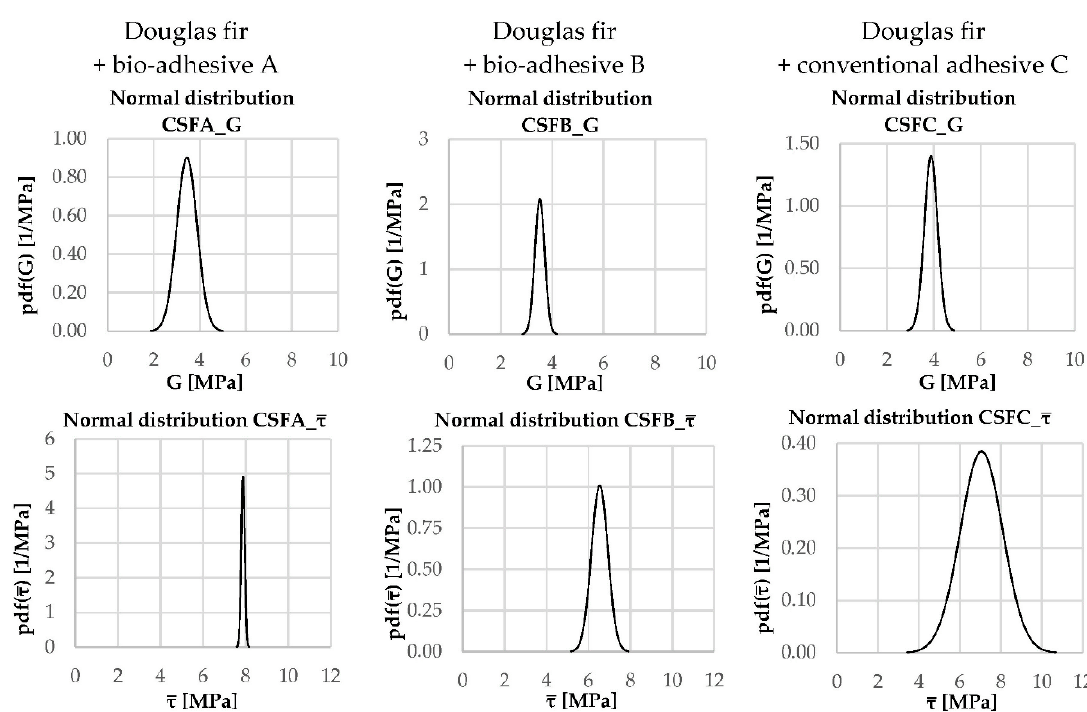
Figure A5. Statistical analysis for shear properties by compression loading on Douglas fir specimens.